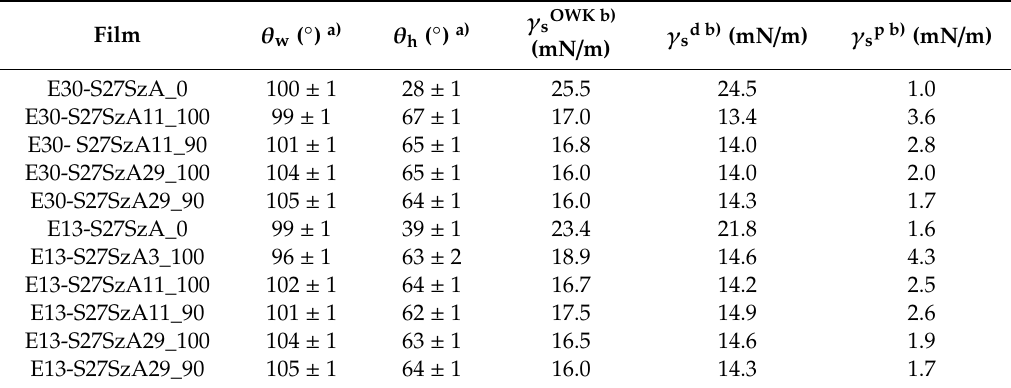
Table 5. Contact angles and surface tensions for the two-layer films and the corresponding SEBS bottom